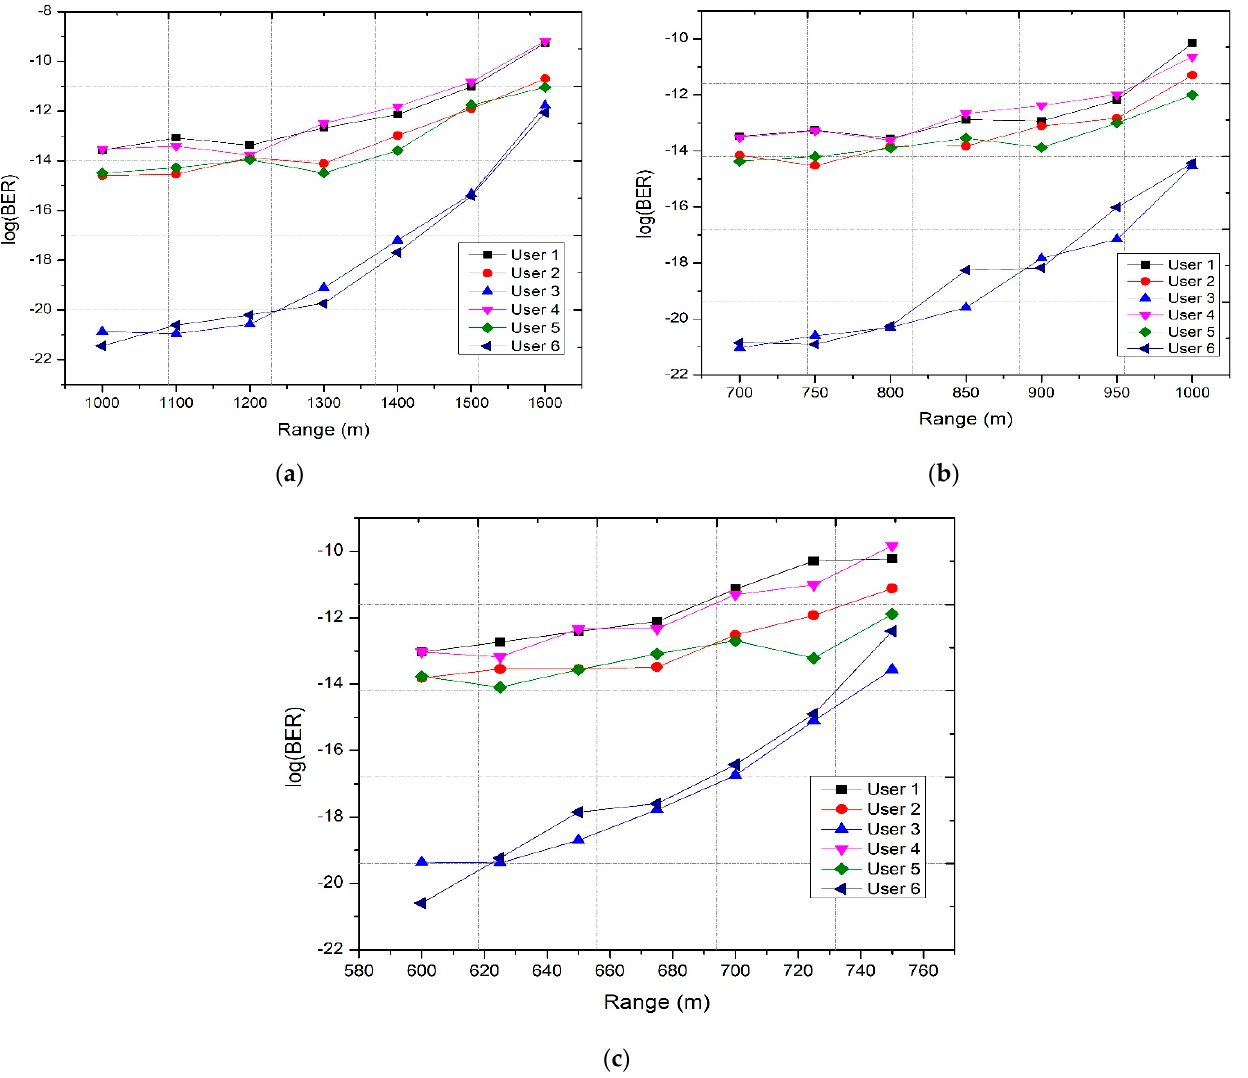
Figure 6. Log(BER) for PDM-SAC-OCDMA-enabled FSO transmission versus range under ( a ) LF, ( b ) MF, ( c ) HF weather. Table 6 summarizes the performance values for six users of PDM-SAC-OCDMA- enabled FSO transmission under fog conditions. Table 6. Performance results for fog